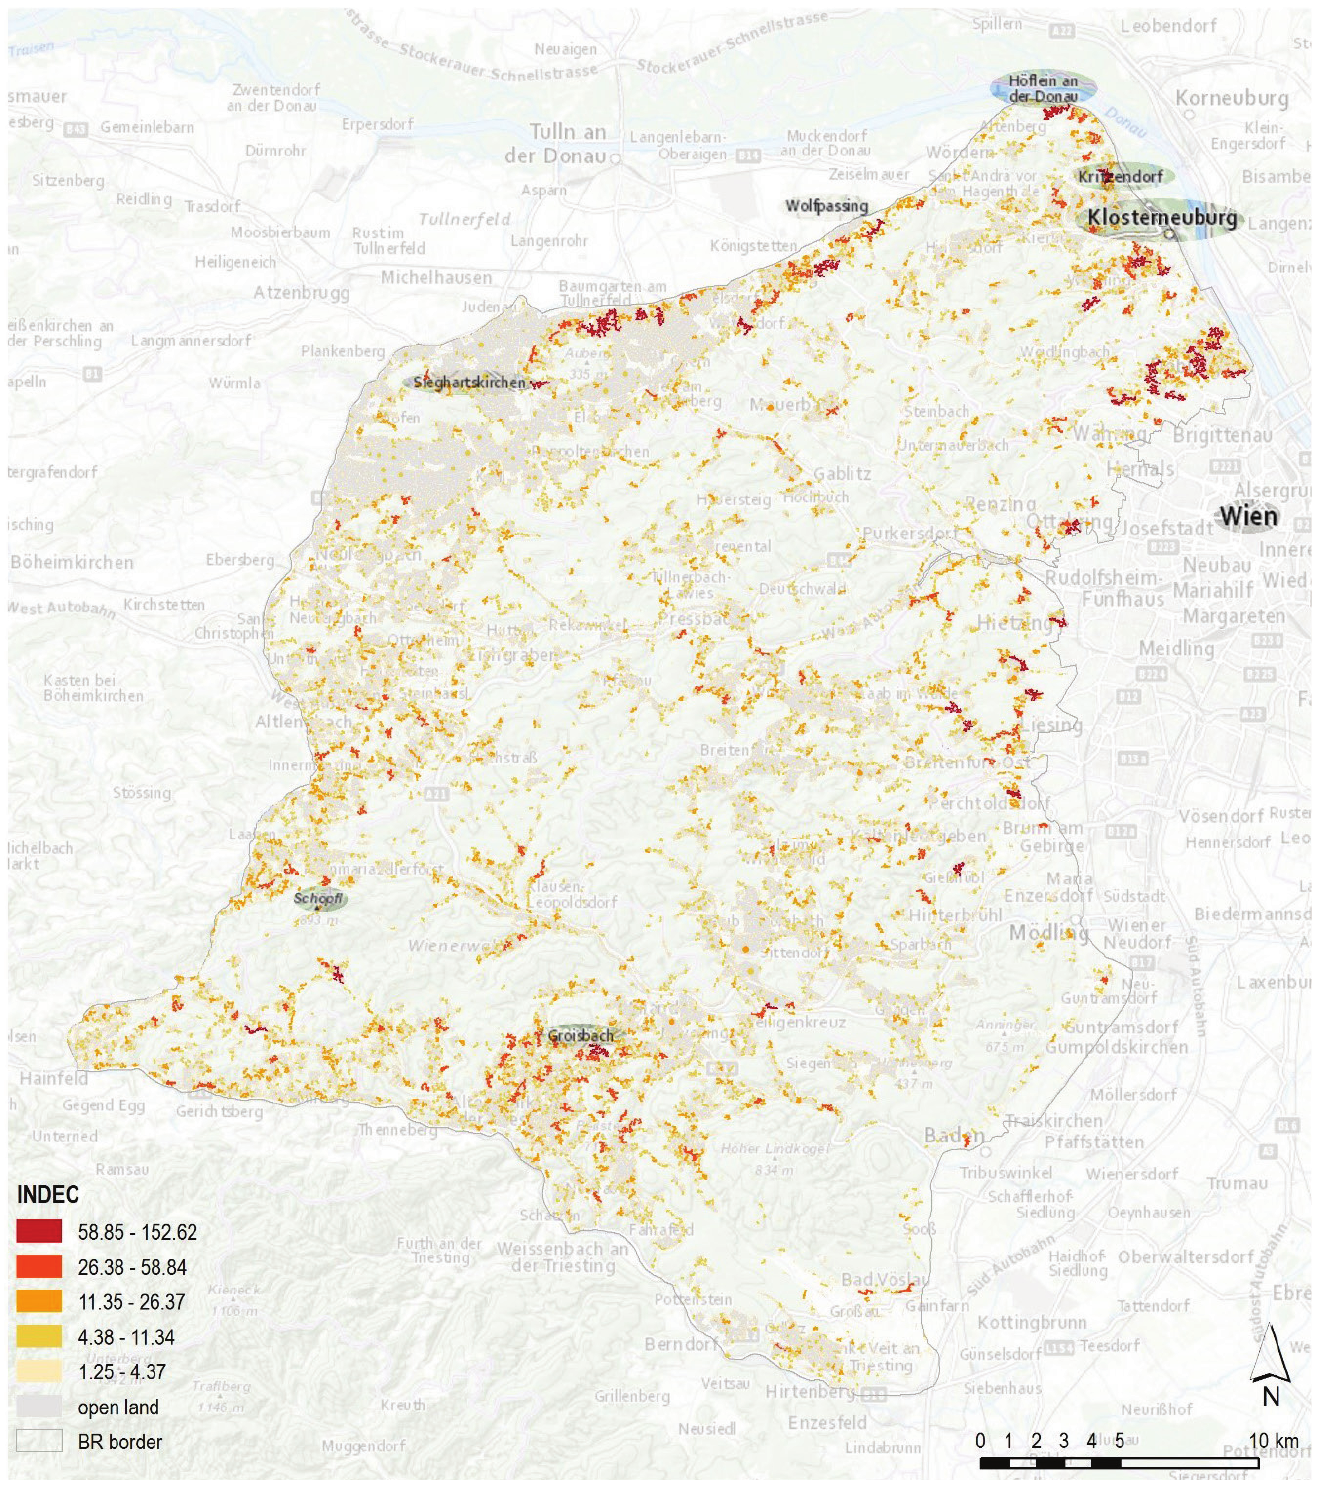
Figure 8: Recreation capacity in the Wienerwald Biosphere Reserve. The colour ramp distinguishes clusters of different INtensity and DEnsity Capacity (INDEC). Data sources: © OpenStreetMap (2018); Staudinger et al. (2014); Wienerwald Tourismus GmbH (2018); www.basemap.at (2018). EPSG: